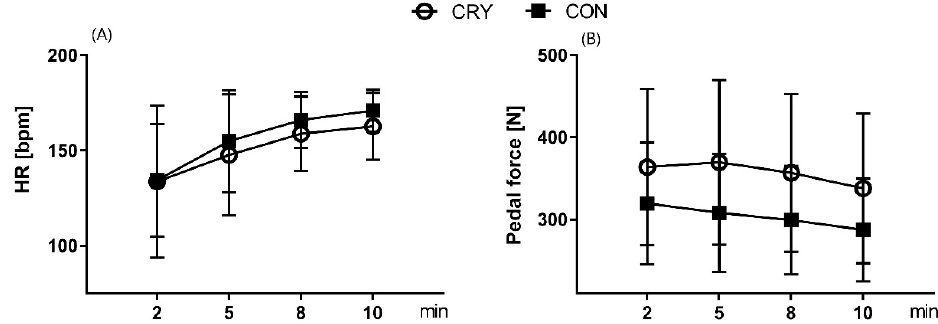
Figure 2. Changes of heart rate (HR) ( A ) and pedal force ( B ) during the second bout of exercise-induced muscle damage. Values between groups were significant di ff erent ( p < 0.05), CRY—cryotherapy group, CON—control group.